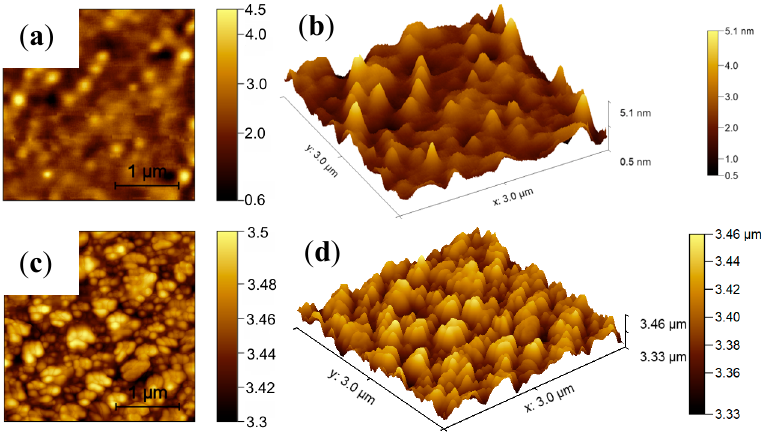
Figure 11. Characteristic 2D atomic force microscopy (AFM) image of HAp ( a ) and 5SmHAp coatings ( c ) and 3D representation of the HAp ( b ) and 5SmHAp ( d ) coatings surface collected on an area of 3 × 3 µm 2 .